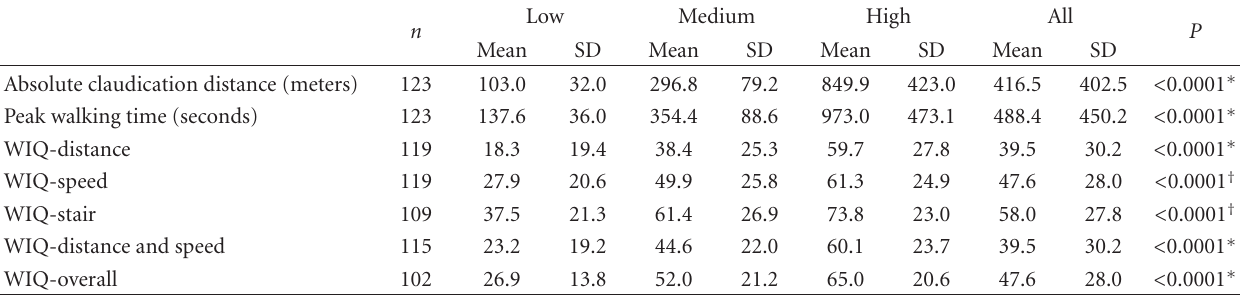
Table 2: WIQ scores categorized by treadmill walking performance as measured by the ACD.